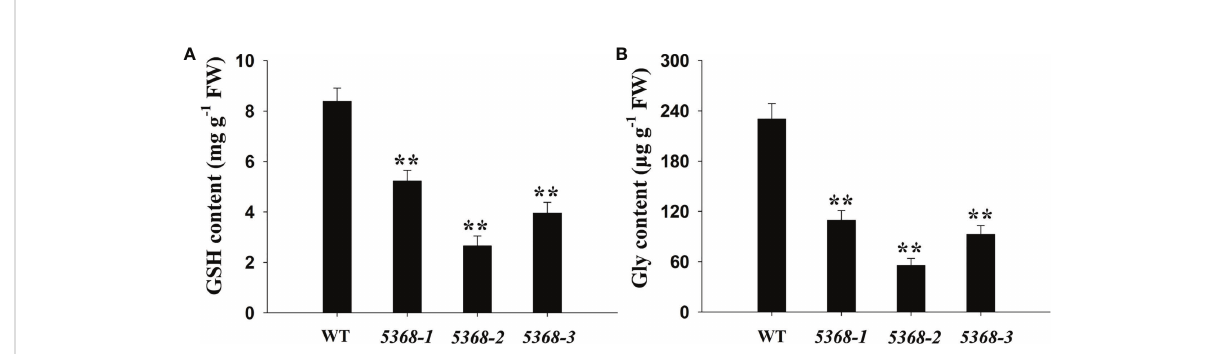
FIGURE 6 Changes in (A) GSH content and (B) Gly content in fl ag leaves between WT and LMM 5386 lines. Values are mean ± SD based on three replicates. Error bars indicate standard deviations. **P <